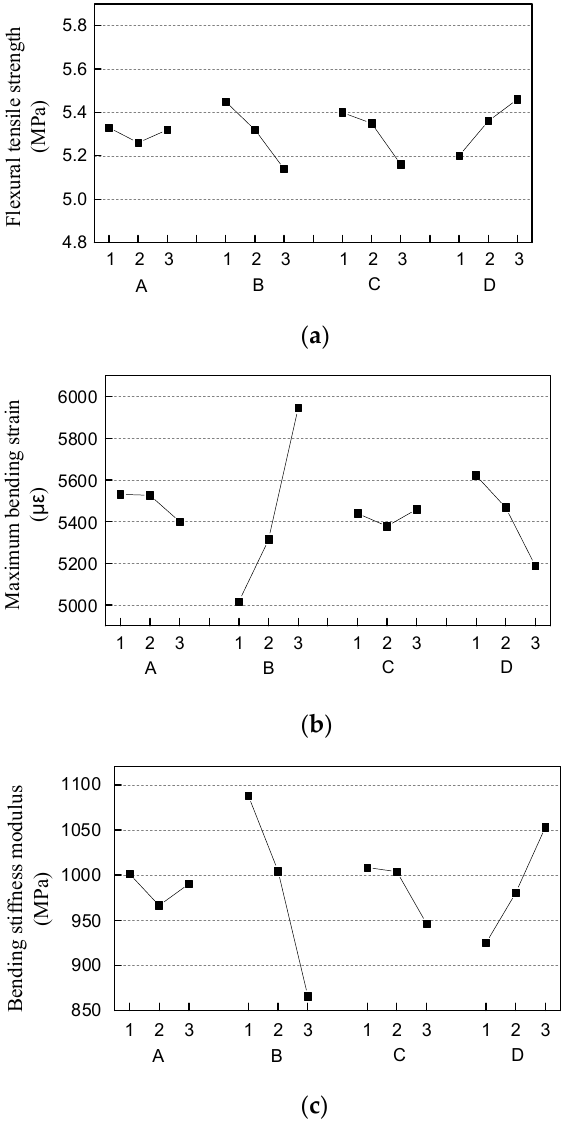
Figure 9. Influence of different levels of each factor on evaluation indicators. ( a ) Curves of flexural tensile strength; ( b ) Curves of maximum bending strain; ( c ) Curves of bending stiffness modulus.